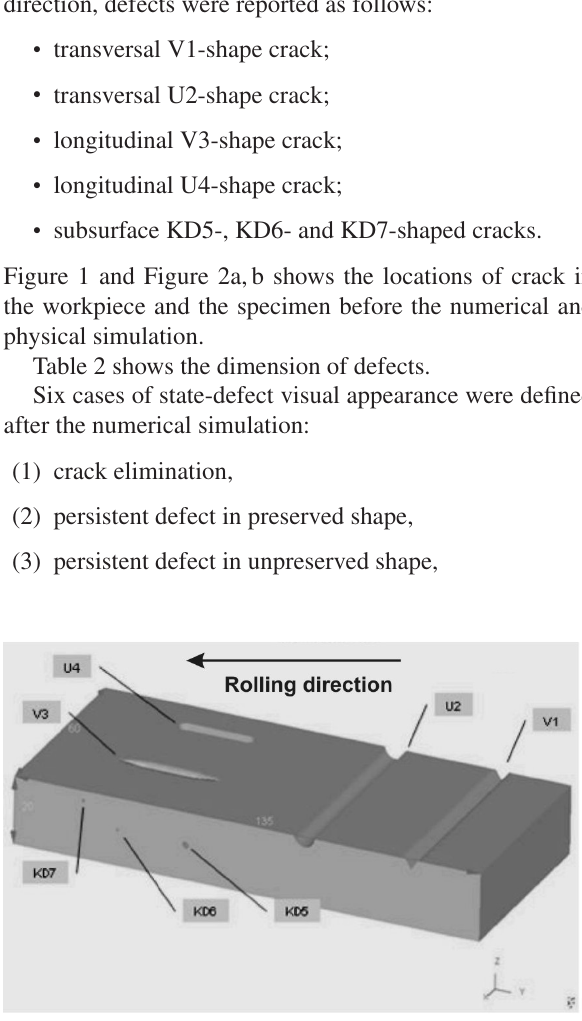
Figure 1. The location of cracks in the workpiece before the numerical simulation.